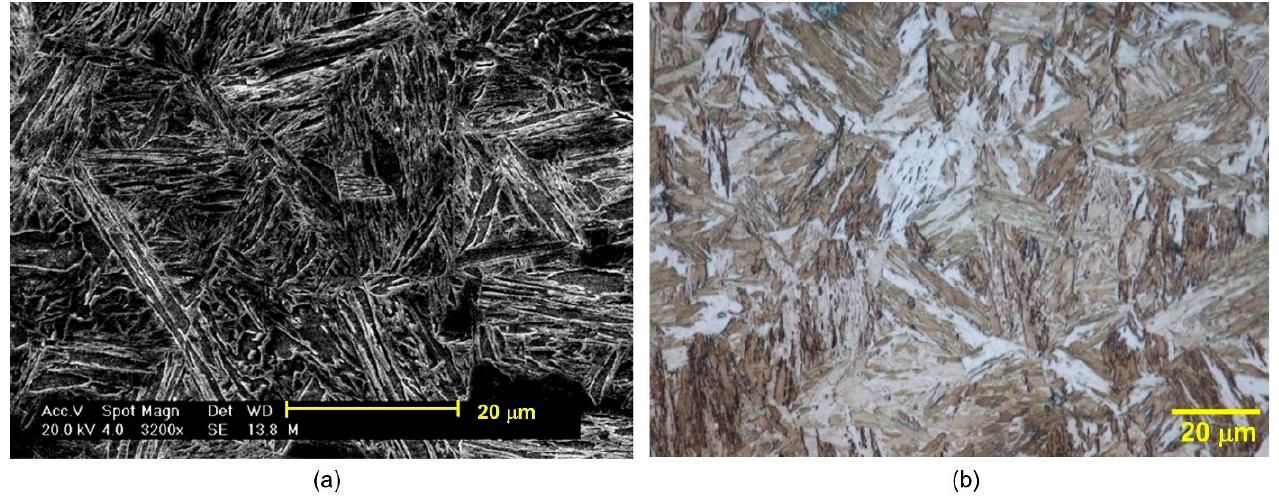
Figure 2. Initial martensitic microstructure: ( a ) Scanning electronic microscopy using secondary electrons; ( b ) Optical image of the microstructure.